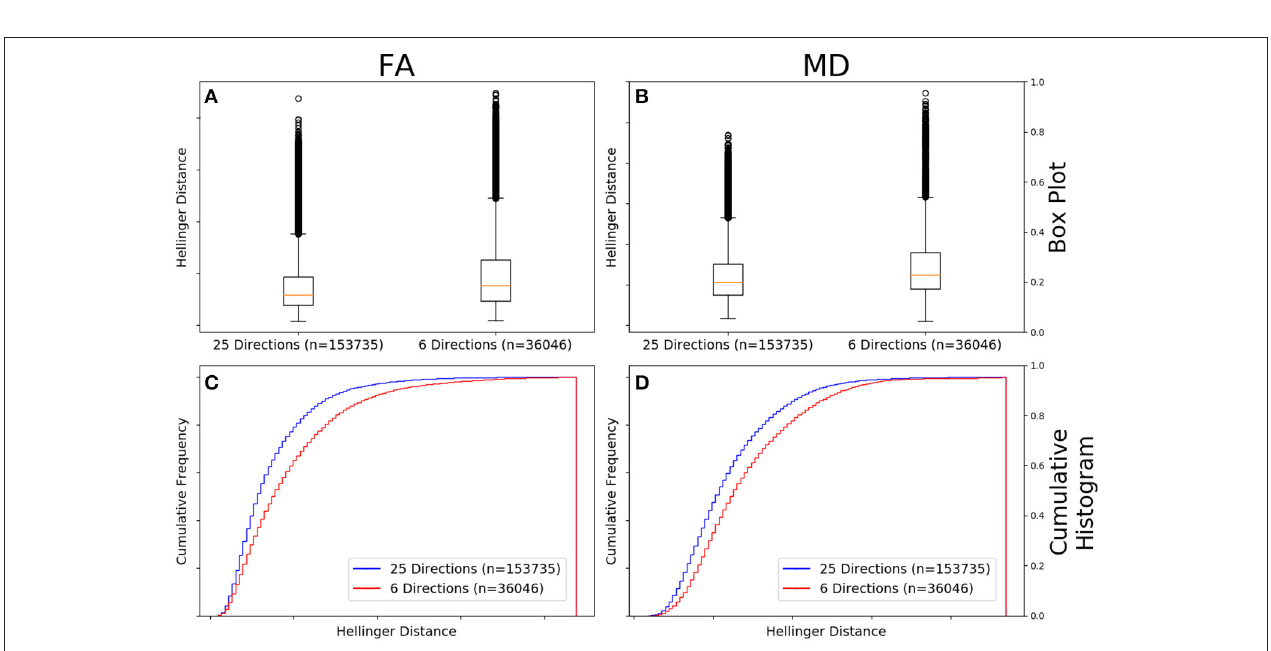
heterogeneous, but ordered nature of brain tissue